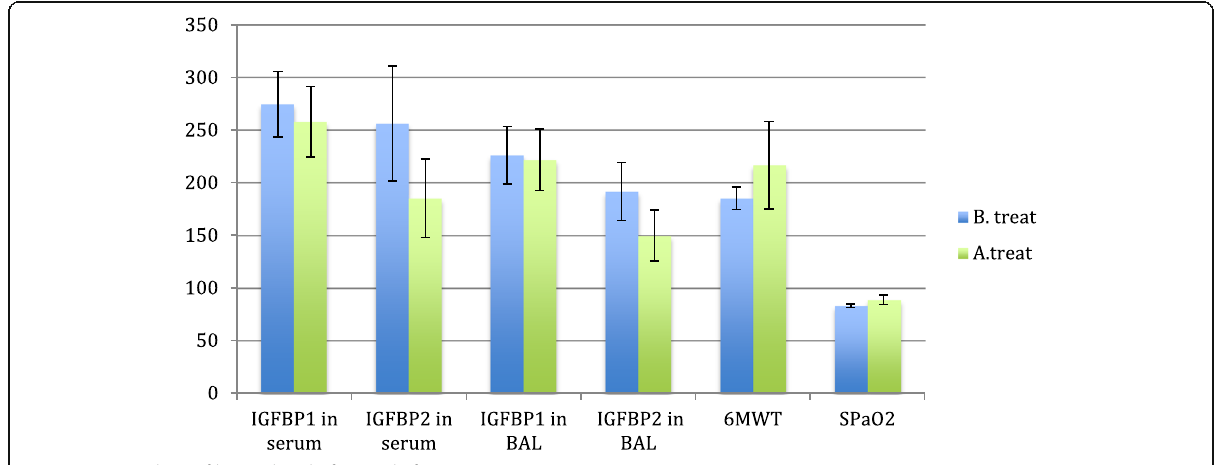
Fig. 1 Mean and SD of biomarkers before and after treatment